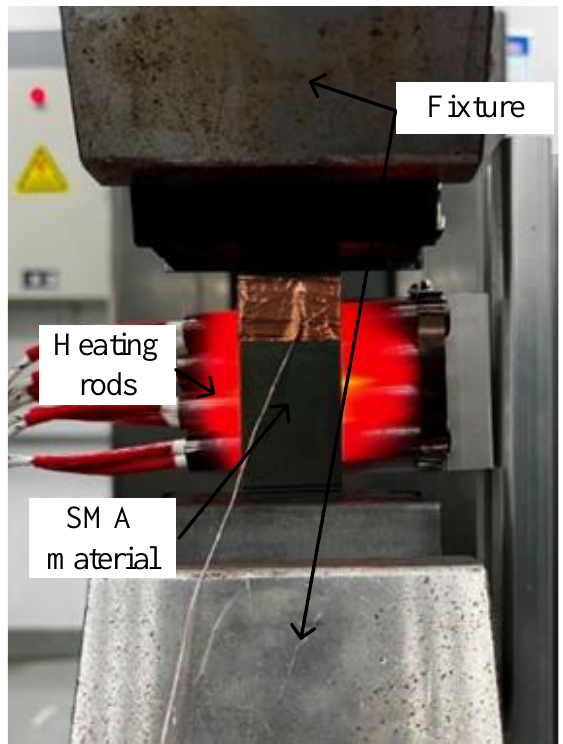
Figure 3. The training system for the SMA strip.